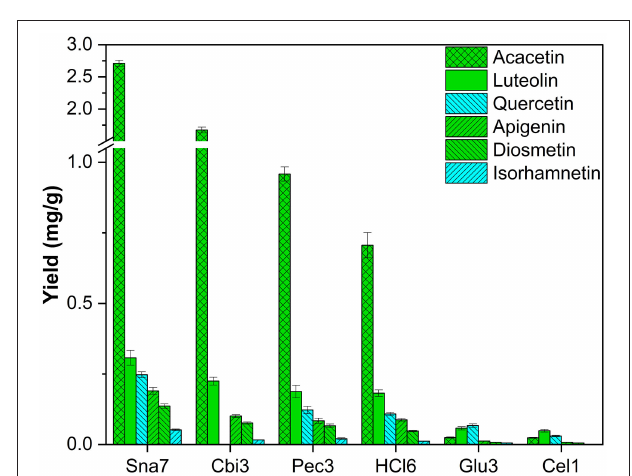
FIGURE 11 | Aglycone yields (mg/g) from leaf extracts of R. pseudoacacia . Enzymatic hydrolysis (25min): Sna7: 5mg Snailase (pH 5.5, 37 ◦ C); Cbi3: 5U Cellobiase (pH 4.5, 37 ◦ C); Pec3: 20U Pectinase (pH 4.5, 40 ◦ C); Glu3: 20U β -Glucosidase (pH 5.5, 37 ◦ C); Cel1: 20U Cellulase (pH 5.5, 52 ◦ C).